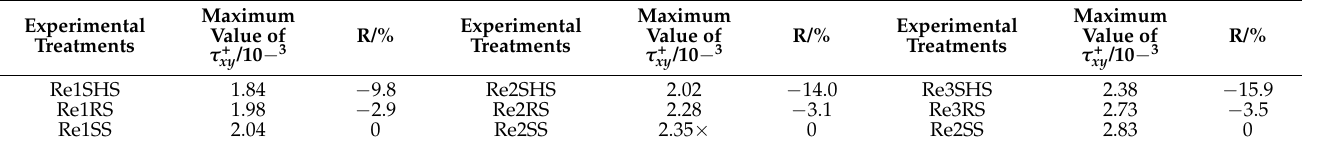
Table 2. Reduction in the maximum Reynolds shear